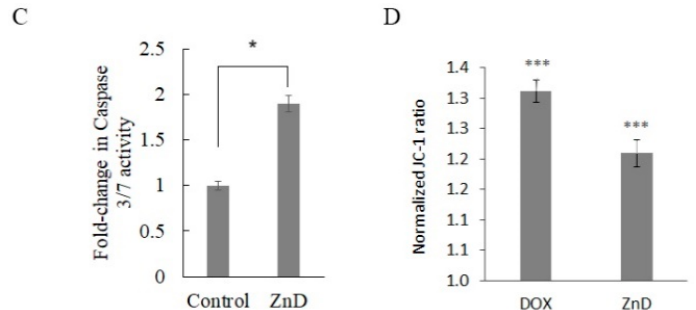
Figure 2. Evaluation of cell death mechanisms. ( A ) Morphological alterations observed after nuclei staining with DNA-specific dye Hoechst 33258 in HCT116 cells exposed to ZnD (IC 50 ; 0.217 µ M) ( A1 ) for 48 h compared to vehicle control (sterile water, A2 ). Orange arrowheads indicate major alterations in nuclear morphology such as chromatin condensation and nuclear fragmentation. ( B ) Caspase 3 / 7 activity of HCT116 cell exposed to ZnD (IC 50 ) or vehicle control (water). The results are expressed as the mean ± SEM percentage normalized to controls from three independent experiments. ( C ) Proportion of apoptotic and necrotic HCT116 cells after a period of incubation (48 h) in the presence of vehicle control (water), ZnCl 2 (0.22 µ M), DION (0.44 µ M), and ZnD (IC 50 = 0.217 µ M). Cell death was determined by flow cytometry after Annexin-V / FITC (fluorescein isothiocyanate) and propidium iodide (PI) double staining. Light gray—viable cells; gray—early apoptosis; dark gray—late apoptosis; black—necrosis. ( D ) Mitochondrial membrane potential of HCT116 cells challenged with ZnD. The fluorescence of the 5,5,6,6-tetrachloro-1,1,3,3 tetraethylbenzimidazolylcarbocyanine iodide (JC-1) monomer, corresponding to green fluorescence, was acquired using filter BL1 (excitation and emission range wavelengths of 488 nm and 515–545 nm, respectively). The fluorescence of the JC-1 aggregate, corresponding to red fluorescence, was acquired using filter BL2 (excitation and emission range wavelengths of 488 nm and 561–587 nm, respectively) JC-1 monomer / aggregate ratio obtained after 48 h incubation of HCT116 cells with doxorubicin and ZnD. Values were normalized to the JC-1 ratio of the control and are represented as the mean ± SD of three independent experiments. * p < 0.05 compared to control; *** p < 0.0005 relative to control.